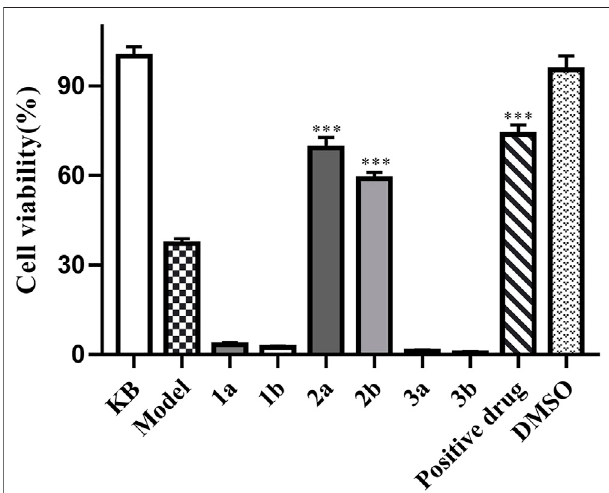
FIGURE 6 | Anti-TNF- α activities of compounds 1 – 3. L929 cells were cultured in the presence of isolated compounds and were measured by the